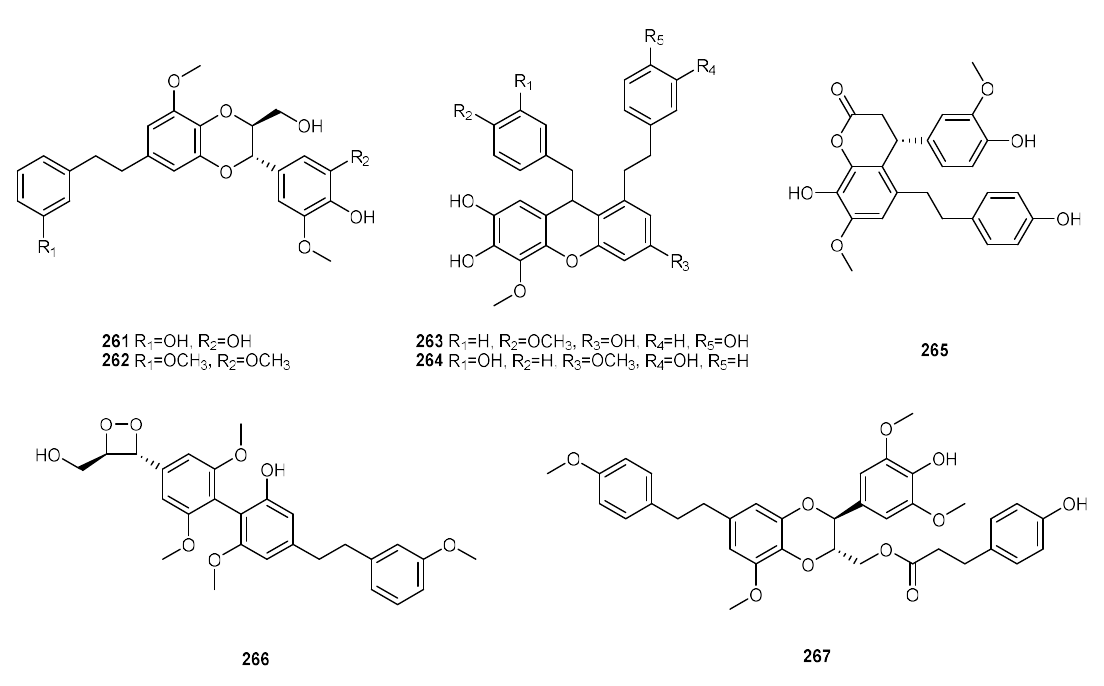
Figure 2. The structures of bibenzyl compounds ( 125–267 ).